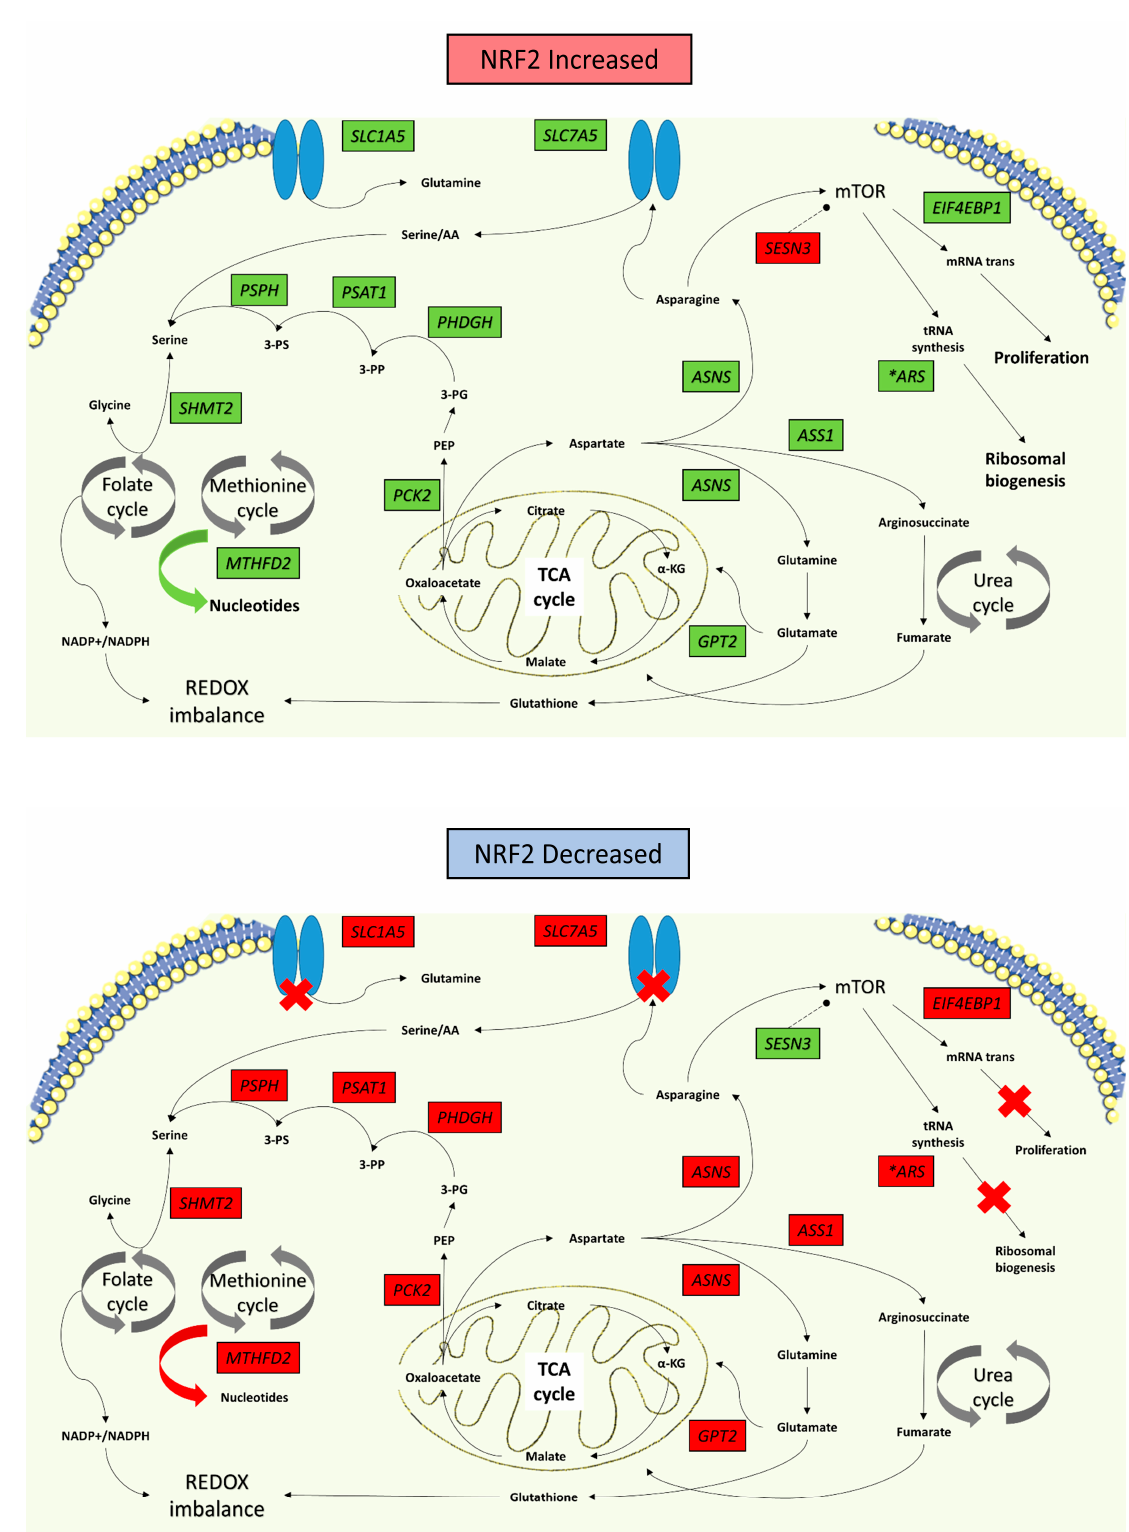
Figure 5. Metabolic ‘switch’ model in response to changes in NRF2. Upregulation of NRF2 facilitates an anabolic process of nucleotide production, mTOR signalling which increases cell proliferation and ribosomal biogenesis. It also impairs the cell’s ability to maintain redox homeostasis. Downregulation of NRF2 produces the reverse effect, abrogating many essential cell mechanisms required for cell survival, crucial to survival following radiation induced damage. The cell circuit diagram summarises the changes produced by the relative change in gene expression (green = upregulated; red =